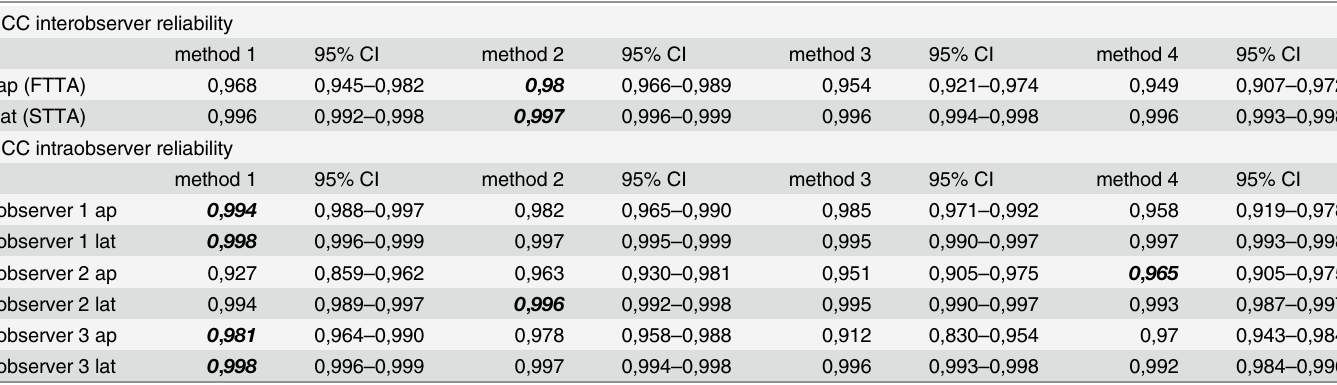
Table 2. Inter- and Intraobserver Reliability.